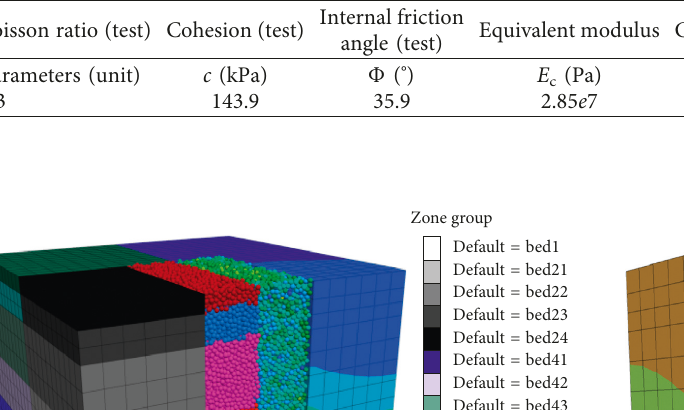
Table 1: Testing mesoscopic parameters.